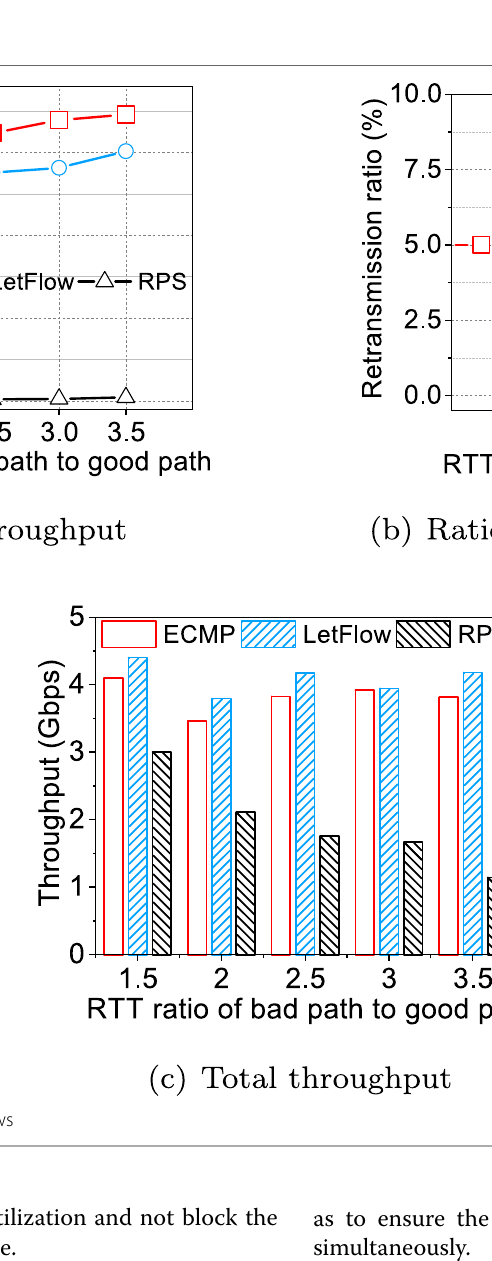
paths to maintain high link utilization and not block the short flows as much as